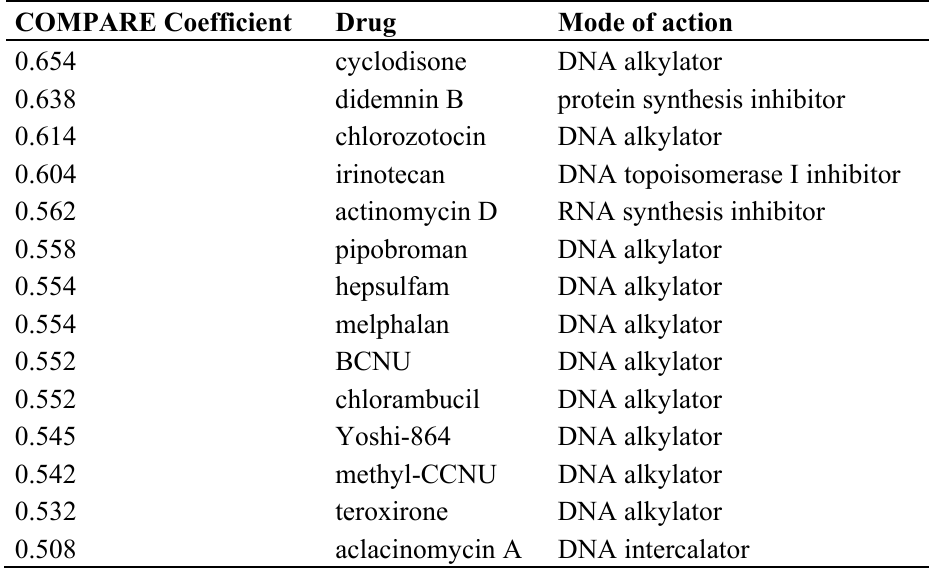
Table 2. Correlation of log acetoside and standard and marketed drugs as investigated by COMPARE